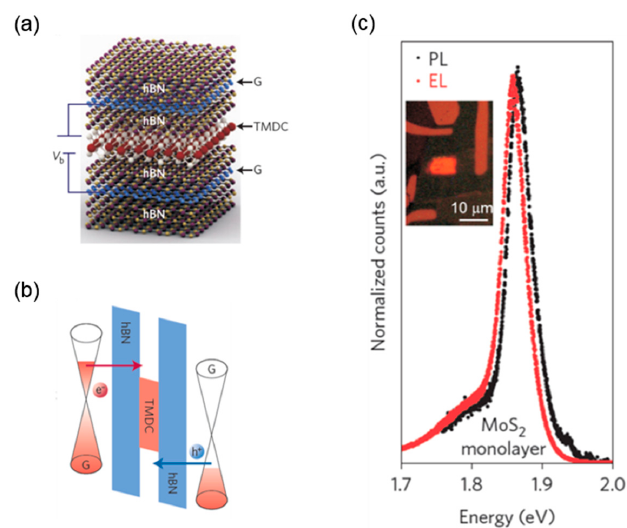
Figure 8. Light ‐ emitting devices based on the 2D vdW heterostructure of graphene/ h ‐ BN/TMDC/ h ‐ BN/graphene: ( a ) schematic diagram; and ( b ) band alignment of the heterostructure; and ( c ) PL and EL spectra, and the EL image (inset) measured from the device. Reproduced with permission from [82]. Copyright Nature, 2014.